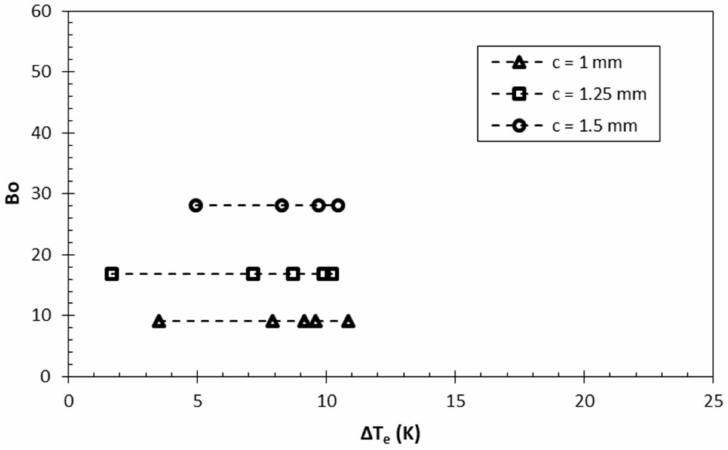
Figure 16. The plot of Bond number from different rectangular pin fin gaps.